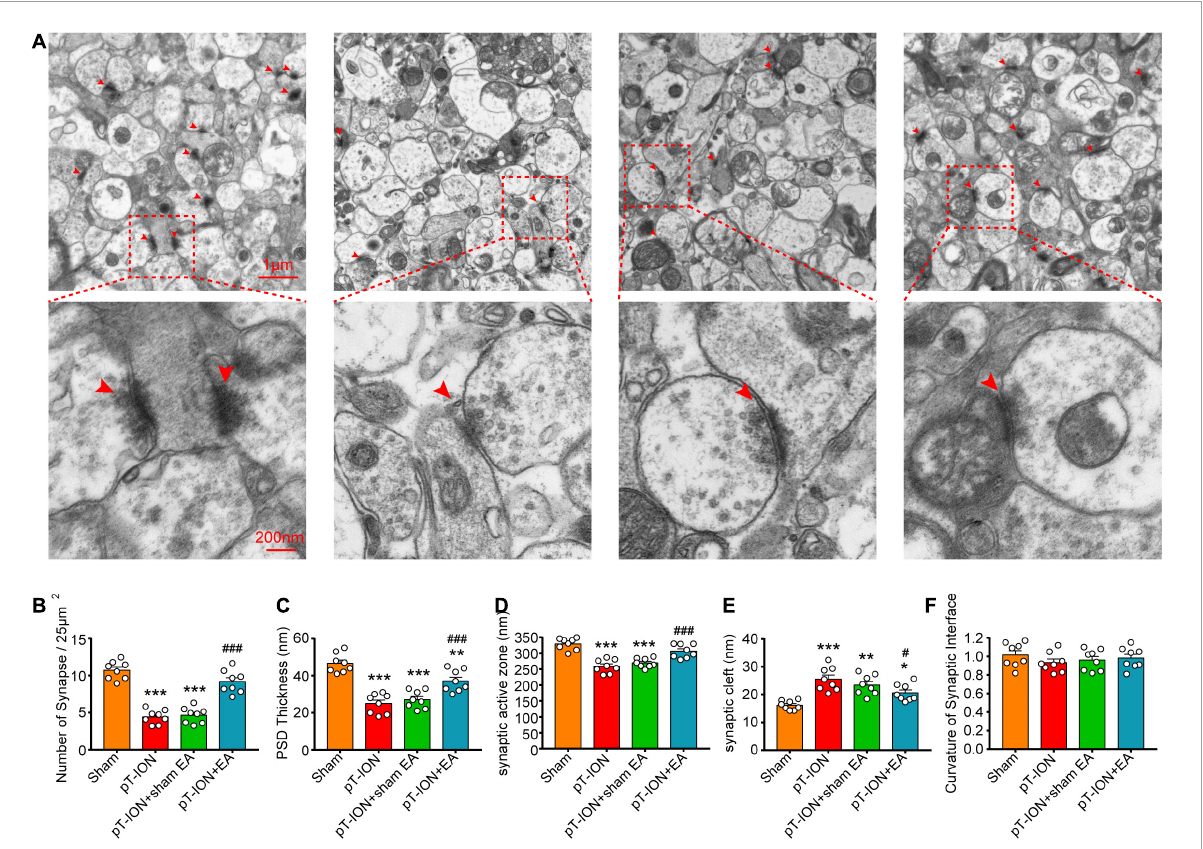
FIGURE6 Protective electroacupuncture (EA) effects on density and ultrastructure of synapses in the CA1 hippocampal region of pT-ION mice. (A) Representative transmission electron microscopy (TEM) images showing the density and ultrastructure of synapses of the CA1 region in each group. The bar graphs show the number of synapses/25 ◦ µ m 2 (B) , the thickness of the postsynaptic densities (PSD) (C) , the length of the synaptic active zone (D) , the width of the synaptic cleft (E) , and the curvature of the synaptic interface (F) in each group. N = 8 mice/group, * P < 0.05, ** P < 0.01, and *** P < 0.001 vs. sham group; # P < 0.05 and ### P < 0.01 vs. pT-ION group, one-way ANOVA and Tukey’s